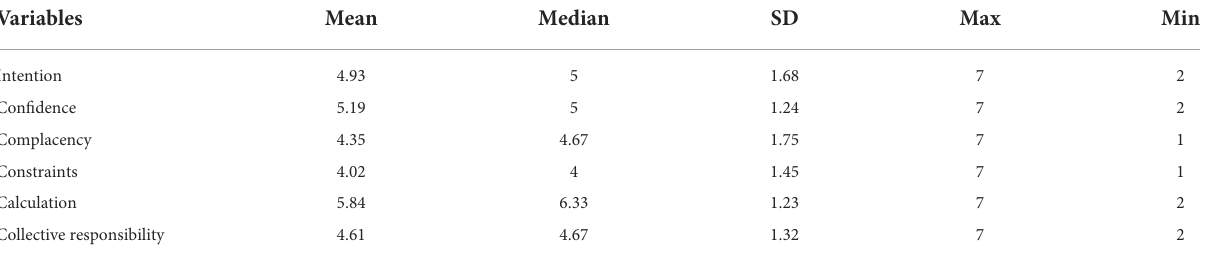
TABLE 3 Descriptive statistics of antecedent and outcome variables.